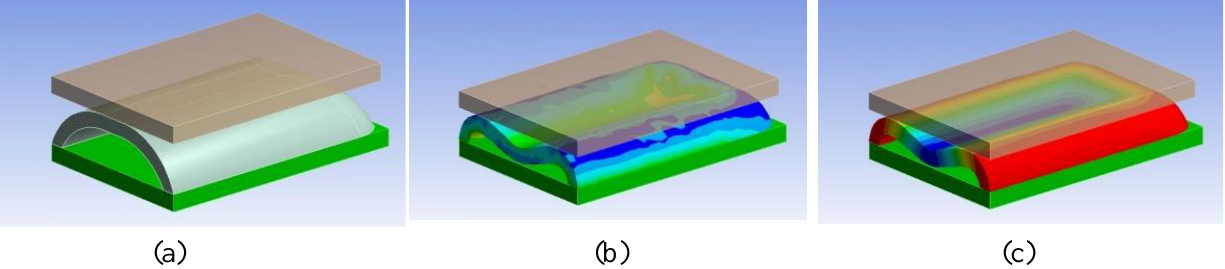
Figure 3. 3D CAD representation of the simulated setup. In transparent brown, the rigid flat indenter, in grey, the silicone structure and in green, the PCB. (a) Undeformed structure. (b) Map of total stress. Blue corresponds to higher stress areas, green to lower stress areas. (c) Map of total deformation. In blue, the areas suffering a bigger